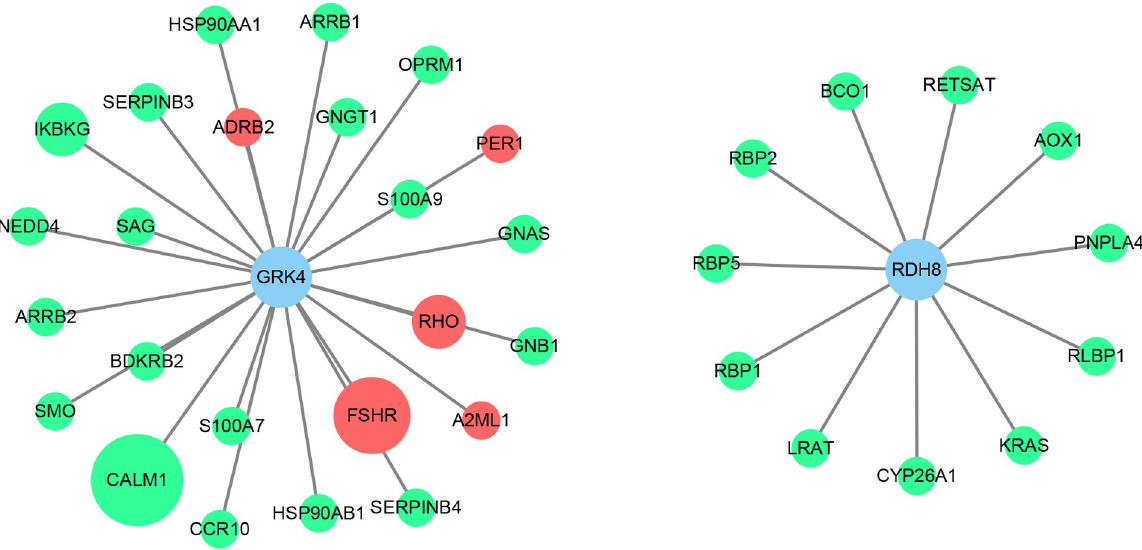
Fig 3. Protein-protein interaction network. Red: genes have been reported to be related to hypertension. No evidence has been provided to correlate green genes with hypertension. The larger the circle, the more databases query this interaction relationship ( CALM1 was queried in five databases; FSHR in four; RHO and IKBKG in two; whereas others in one database).